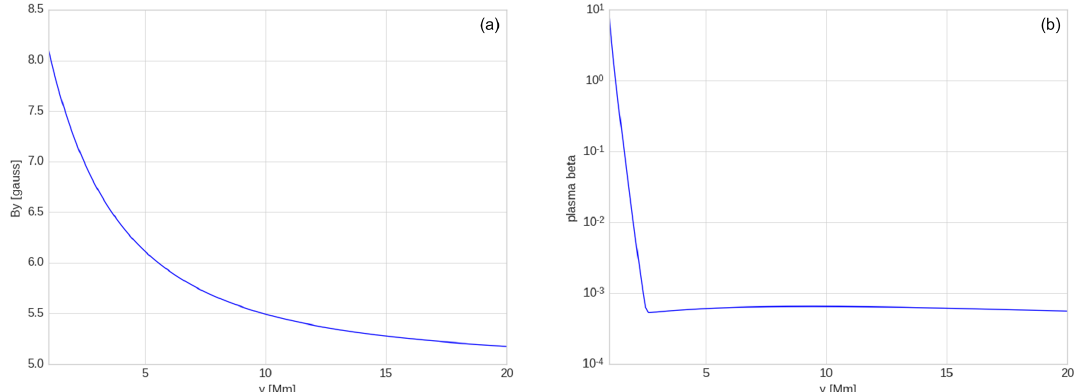
Figure 3. Magnetic field profile (a) and plasma beta profile (b) vs. height ( y ) in the model quiet solar